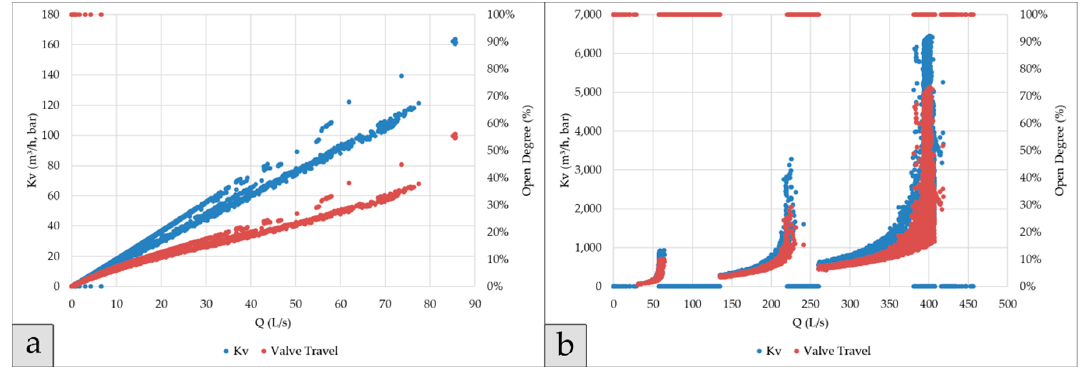
Figure 11. ( a ) Kv and valve travel for each registered flow for the bypass valve. ( b ) Kv and open degree for each registered flow for the bypass valve.